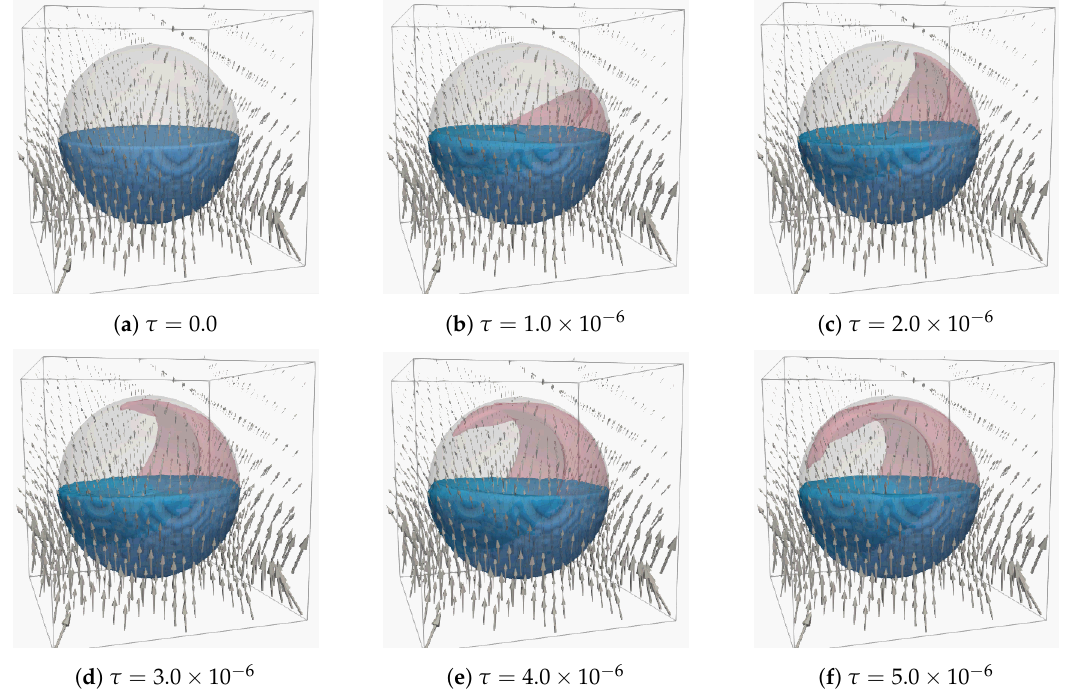
Figure 13. Computational results of Case 4 ( D / L = 2.0, H = 0.0, b c = 3.0 [T], i.e., coil is larger, closer to the tank and magnetic flux density is strong). The blue color indicates the movement of liquid phase damped by the magnetic force, whereas the pink color indicates that in Case 0 (no magnetic force). The black vectors represent the magnetic field generated by the coil